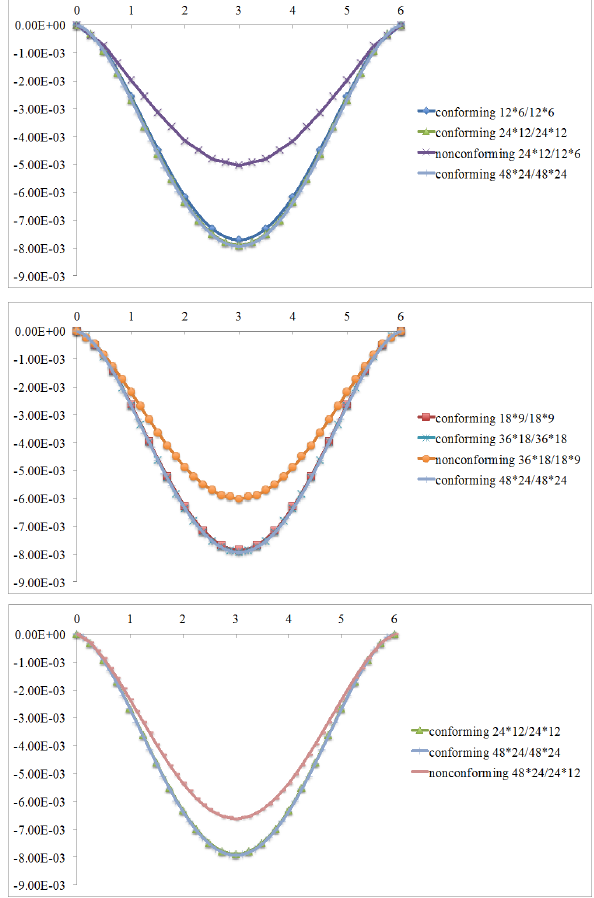
Figure 14: Transverse displacement u 3 distribution for a double- layer shell with Q4 elements using conforming and non-conforming mesh configurations.